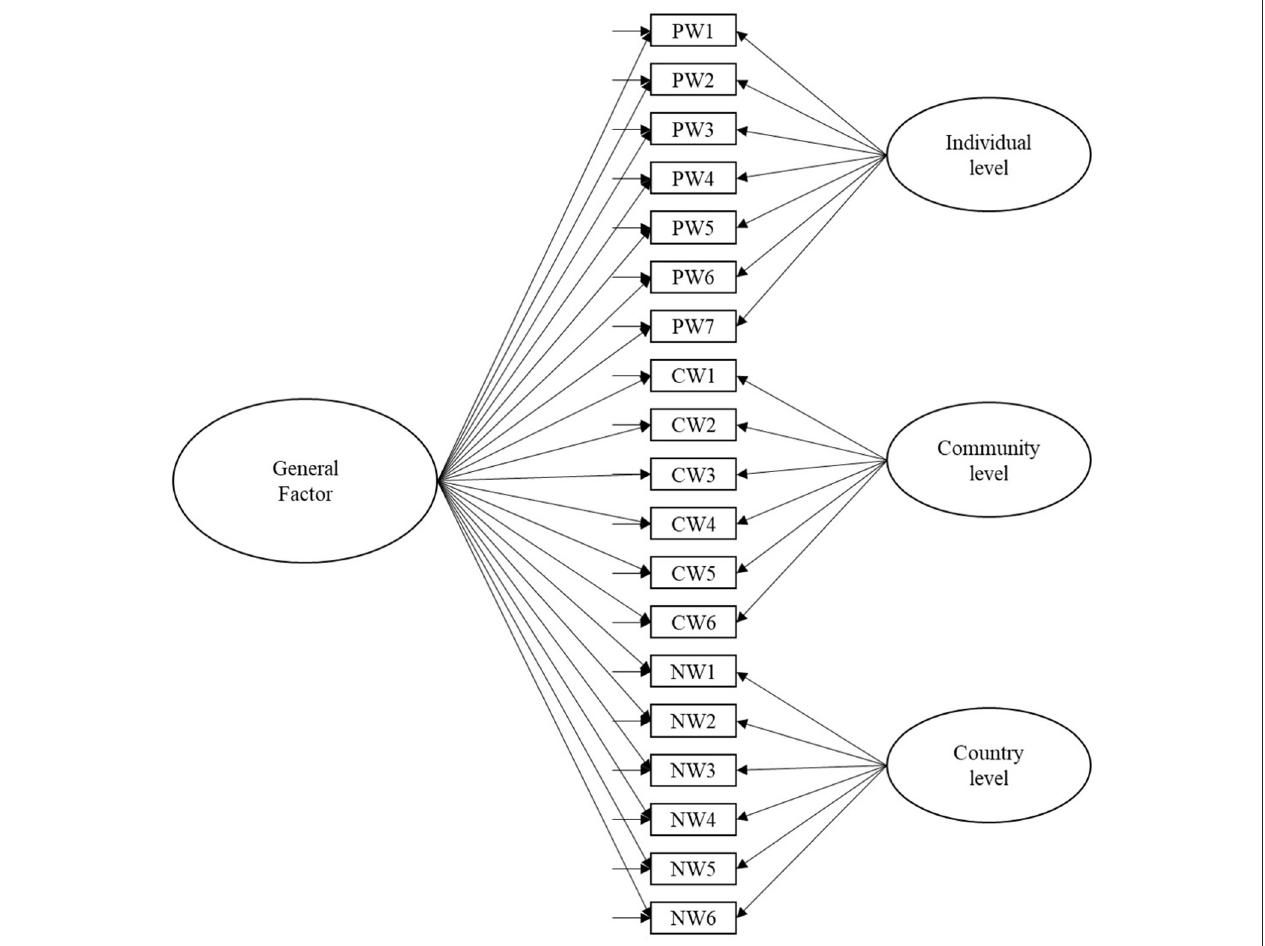
FIGURE 1 | The conceptual bifactor model of subjective